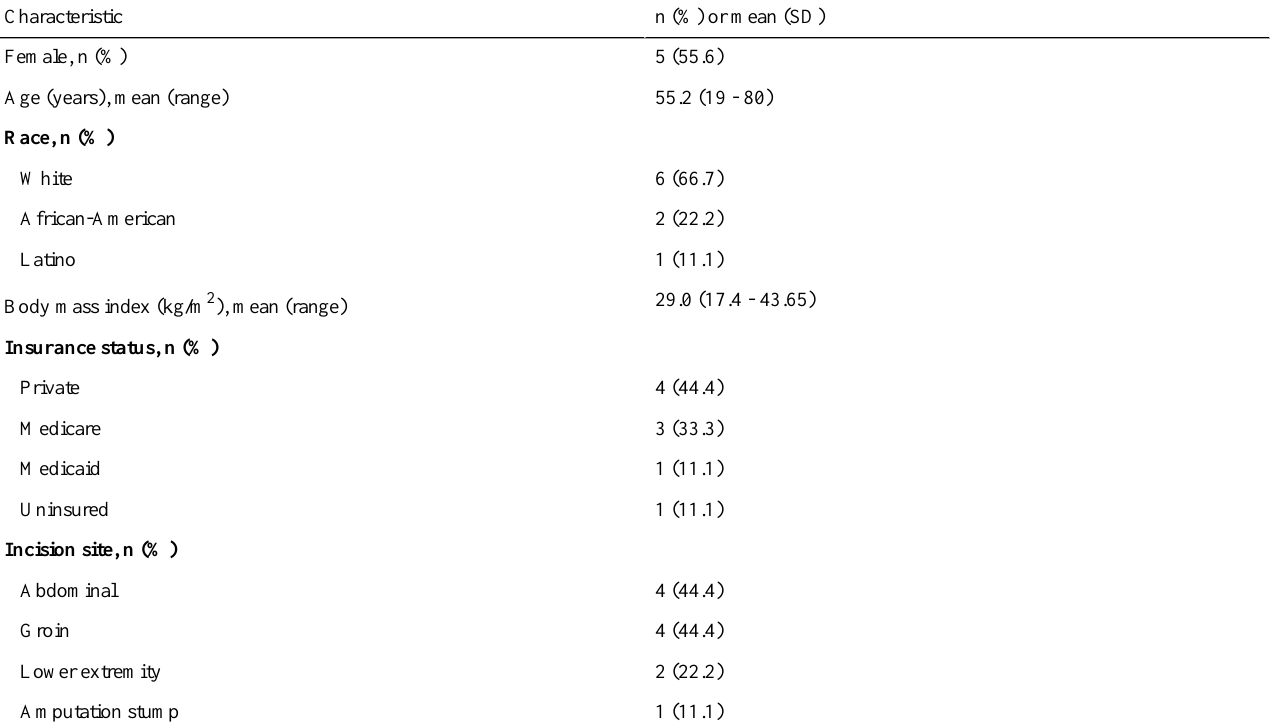
Table 3. Demographic and baseline